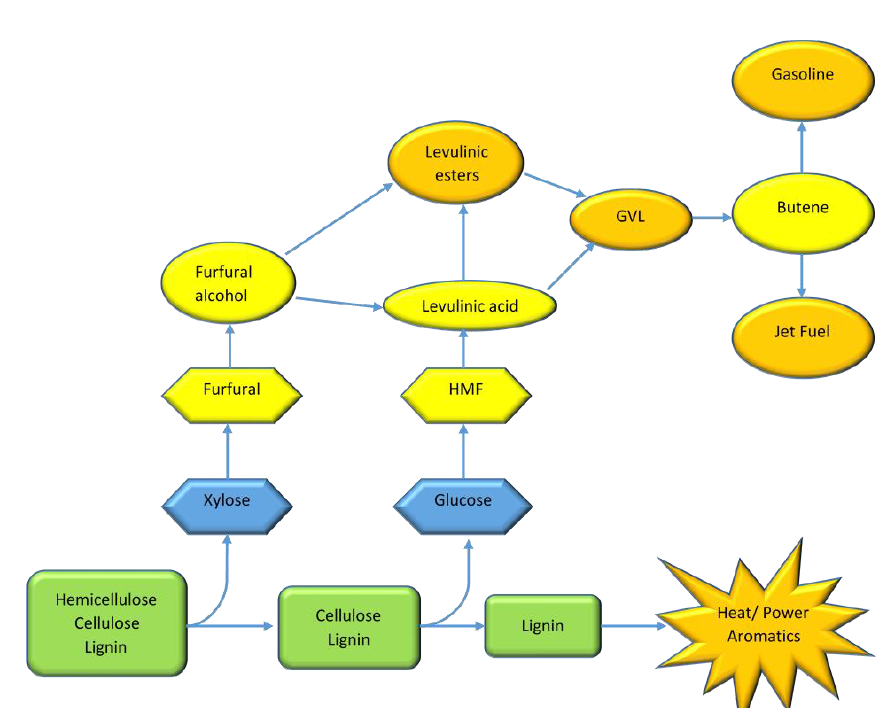
Figure 1. Roadmap for conversion of lignocellulosic biomass (green) to fuels (orange) and chemicals (yellow) passing through the intermediate formation of furfural and levulinic acid from C5 and C6 sugars (blue). Adapted from [12]. Molecules 2021 , 26 , x FOR PEER REVIEW